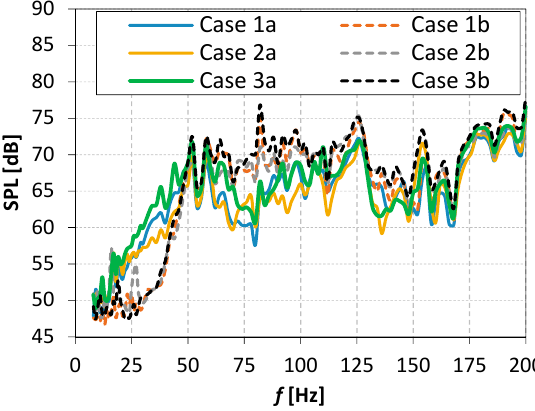
Figure 5. The SPL generated at constant apparent power of P = 4 W.